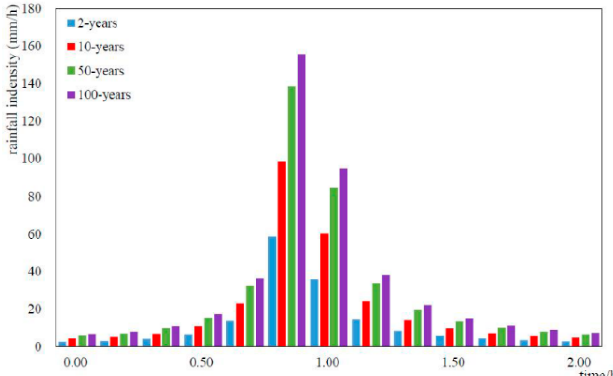
Figure 3. The hyetography of design storms with different return periods.